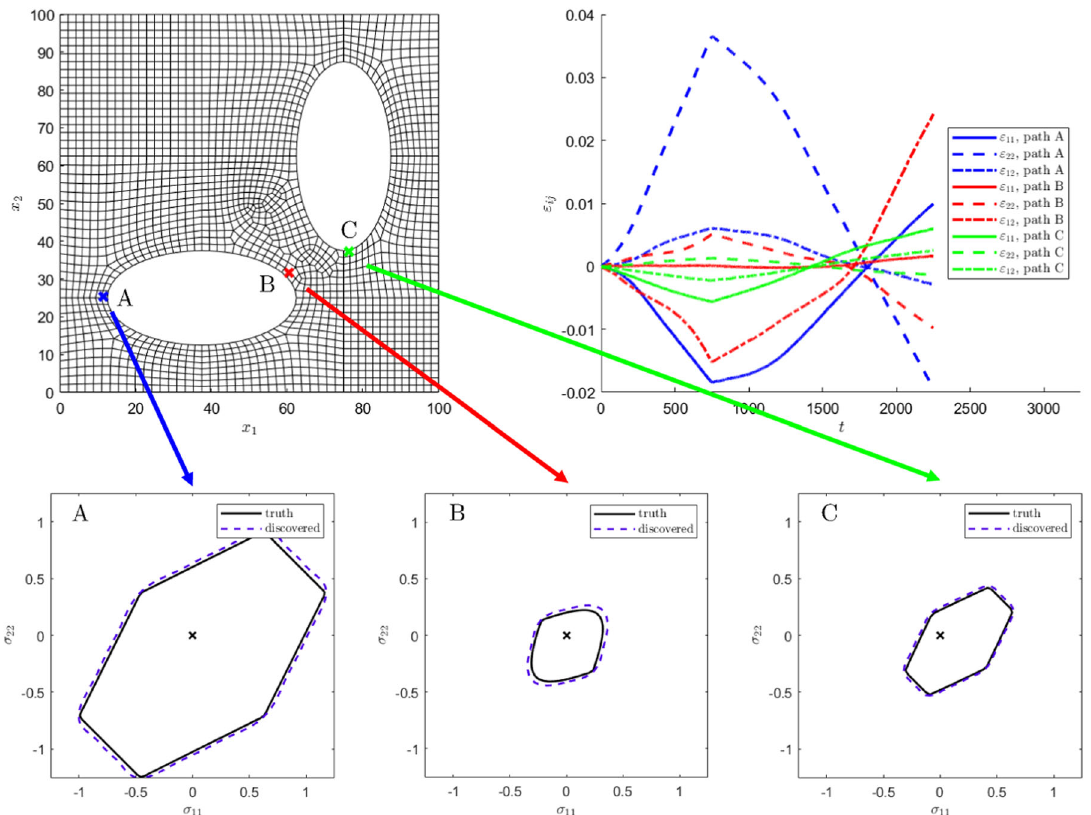
Fig. 4 Yield surface plots of the (true) hidden and discovered Schmidt-Ishlinsky material model (lower row of plots) at the end of three different deformation paths (A, B, C) corresponding to characteristic points in the specimen domain. The locations of the points are illustrated in the upper left part of the fi gure and the strain histories at the different points are shown in the upper right plot. A noise level of σ = 10 − 4 mm was considered and the yield surfaces are plotted at σ